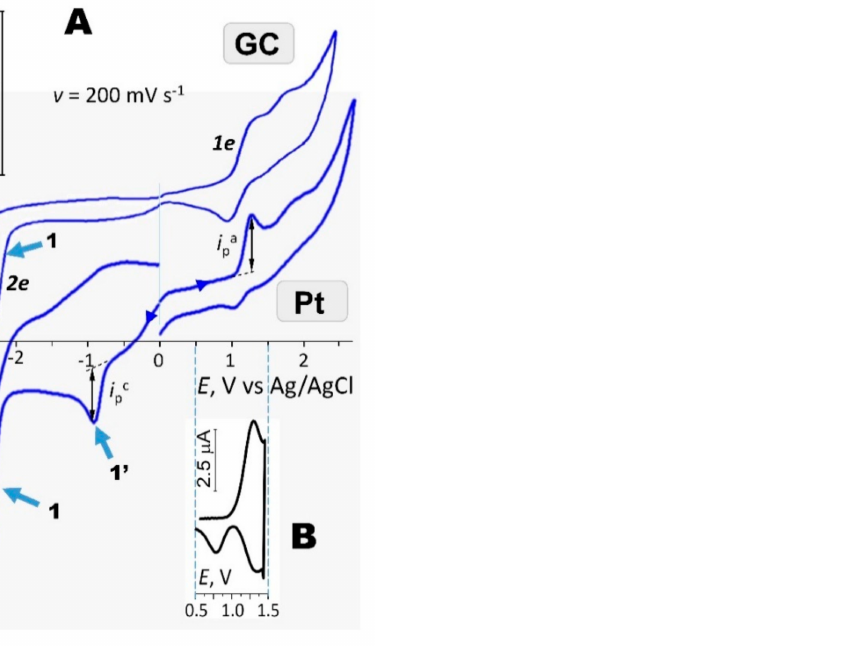
Figure 8. Cyclic ( A ) and square-wave ( B ) voltammetry of 7 in AN/0.1 M Bu 4 NPF 6 . T = 20 ◦ C. Anodic and cathodic scans are traced independently.